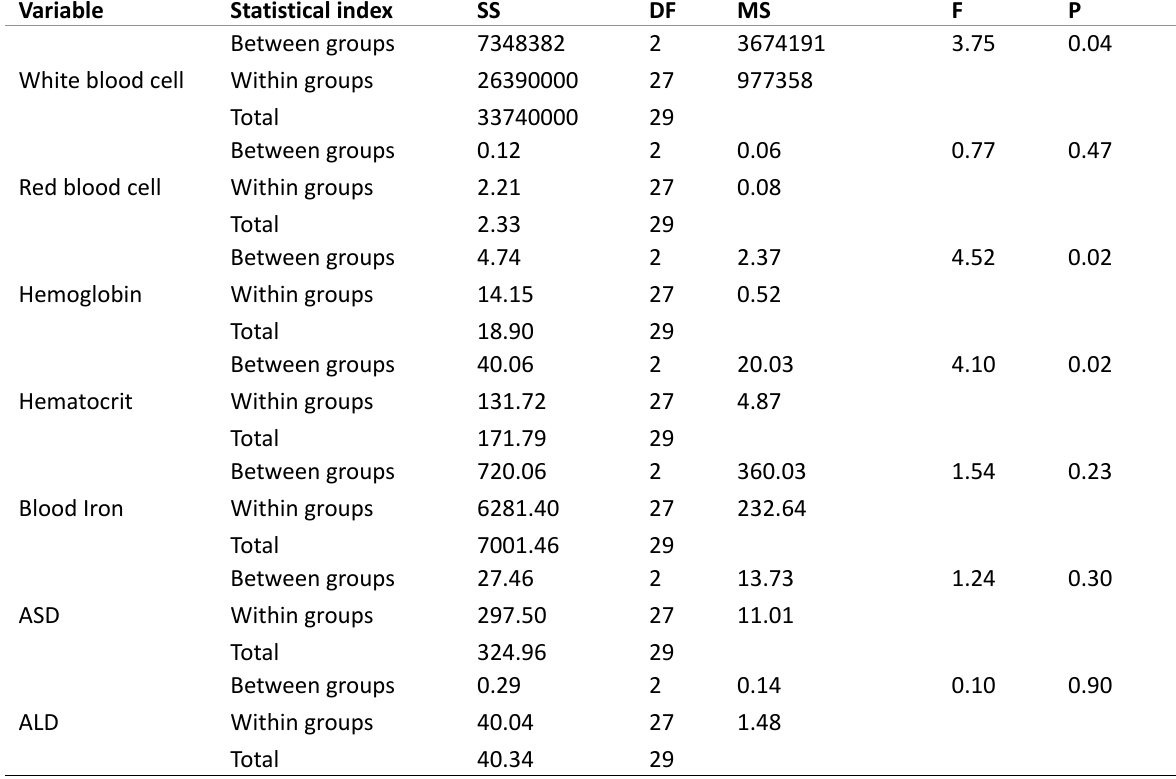
Table 3 . One-way analysis of variance to check three different recovery results on